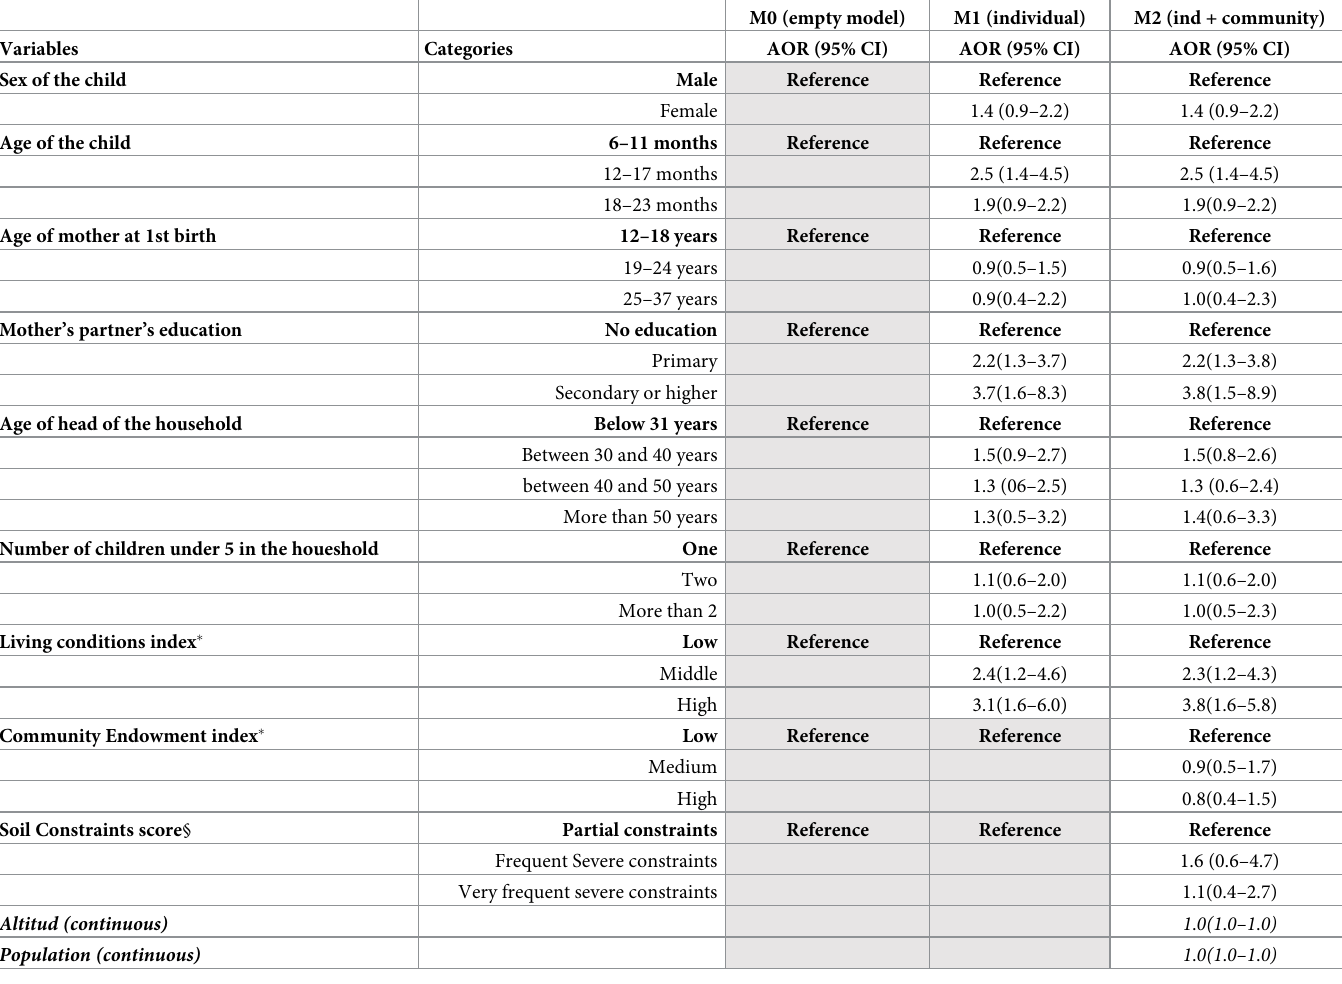
Table 3. Factors associated with MDD-C in rural Burundi DHS2010. Results from the two-level logit regression